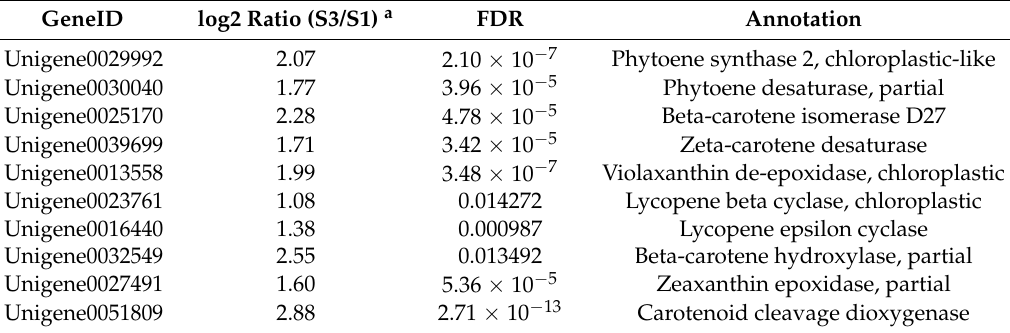
Table 4. Putative carotenoids genes identified from differentially expressed